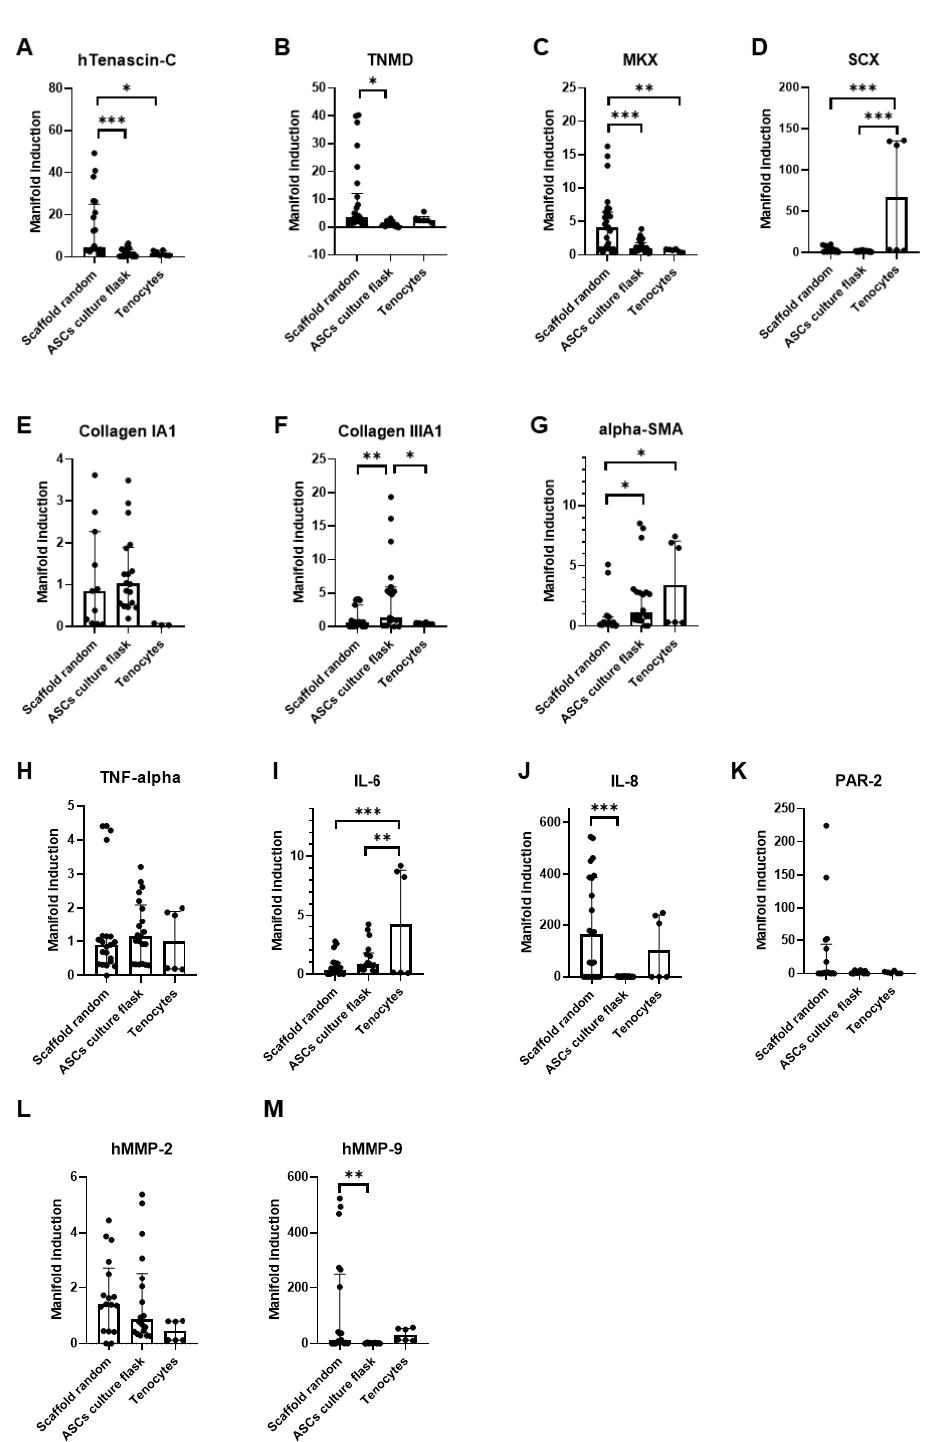
Figure 6. Random PVDFhfp/PDMS under static conditions. Quantitative RT-PCR results of 3 human ASC donors. Statistical analysis was performed with one-way ANOVA and data are shown as median and interquartile range, with * ( p < 0.05), ** ( p < 0.01) and *** ( p < 0.001). ( A ) TNC , ( B ) TNMD , ( C ) MKX